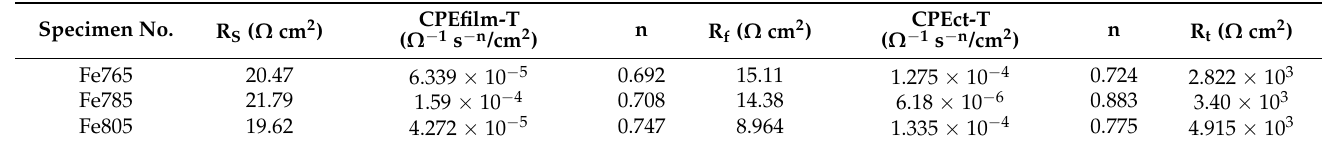
Table 2. Parameters obtained from the simulation circuit in Hank’s solution.